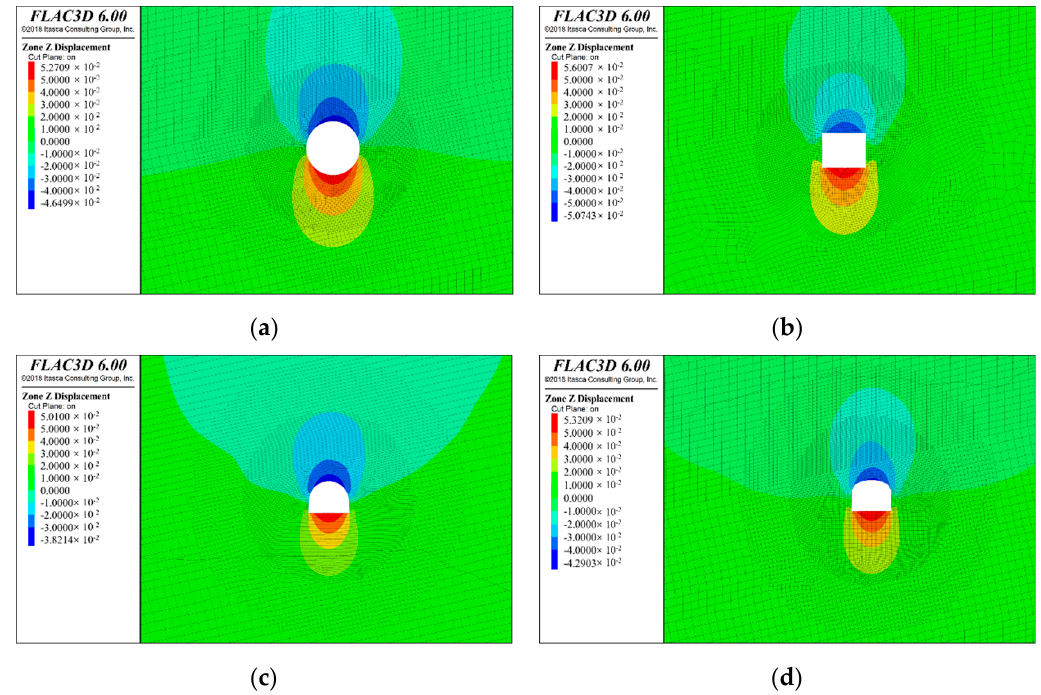
Figure 5. Influence of section shape on the vertical displacement cloud map of the surrounding rock of a bottom drainage roadway. ( a ) Circular section; ( b ) Rectangular section; ( c ) Semicircular arch section; ( d ) Three-center arch section.